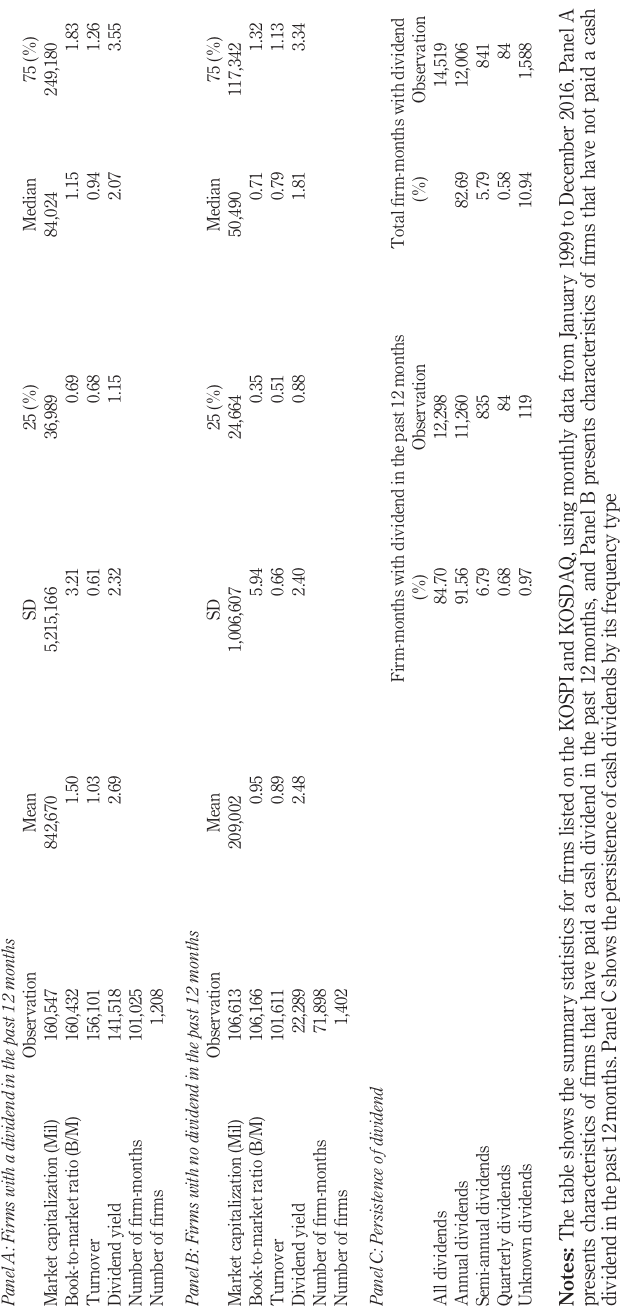
Table 2. Summary